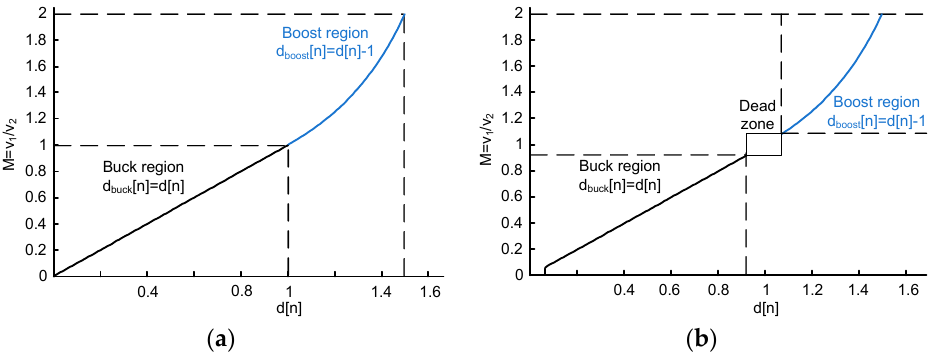
Figure 2. ( a ) Ideal conversion ratio as a function of the duty cycle. ( b ) Dead zones.